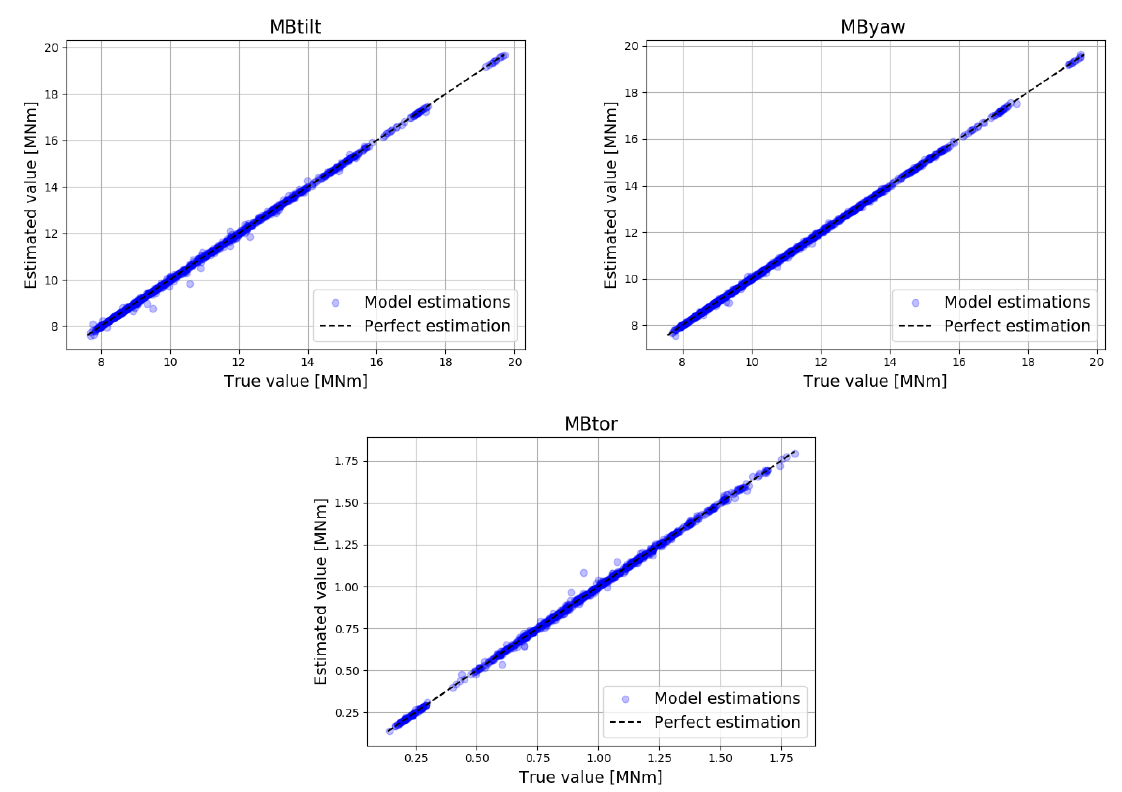
Figure 7. MBtilt, MByaw and MBtor estimated and observed values for GPR